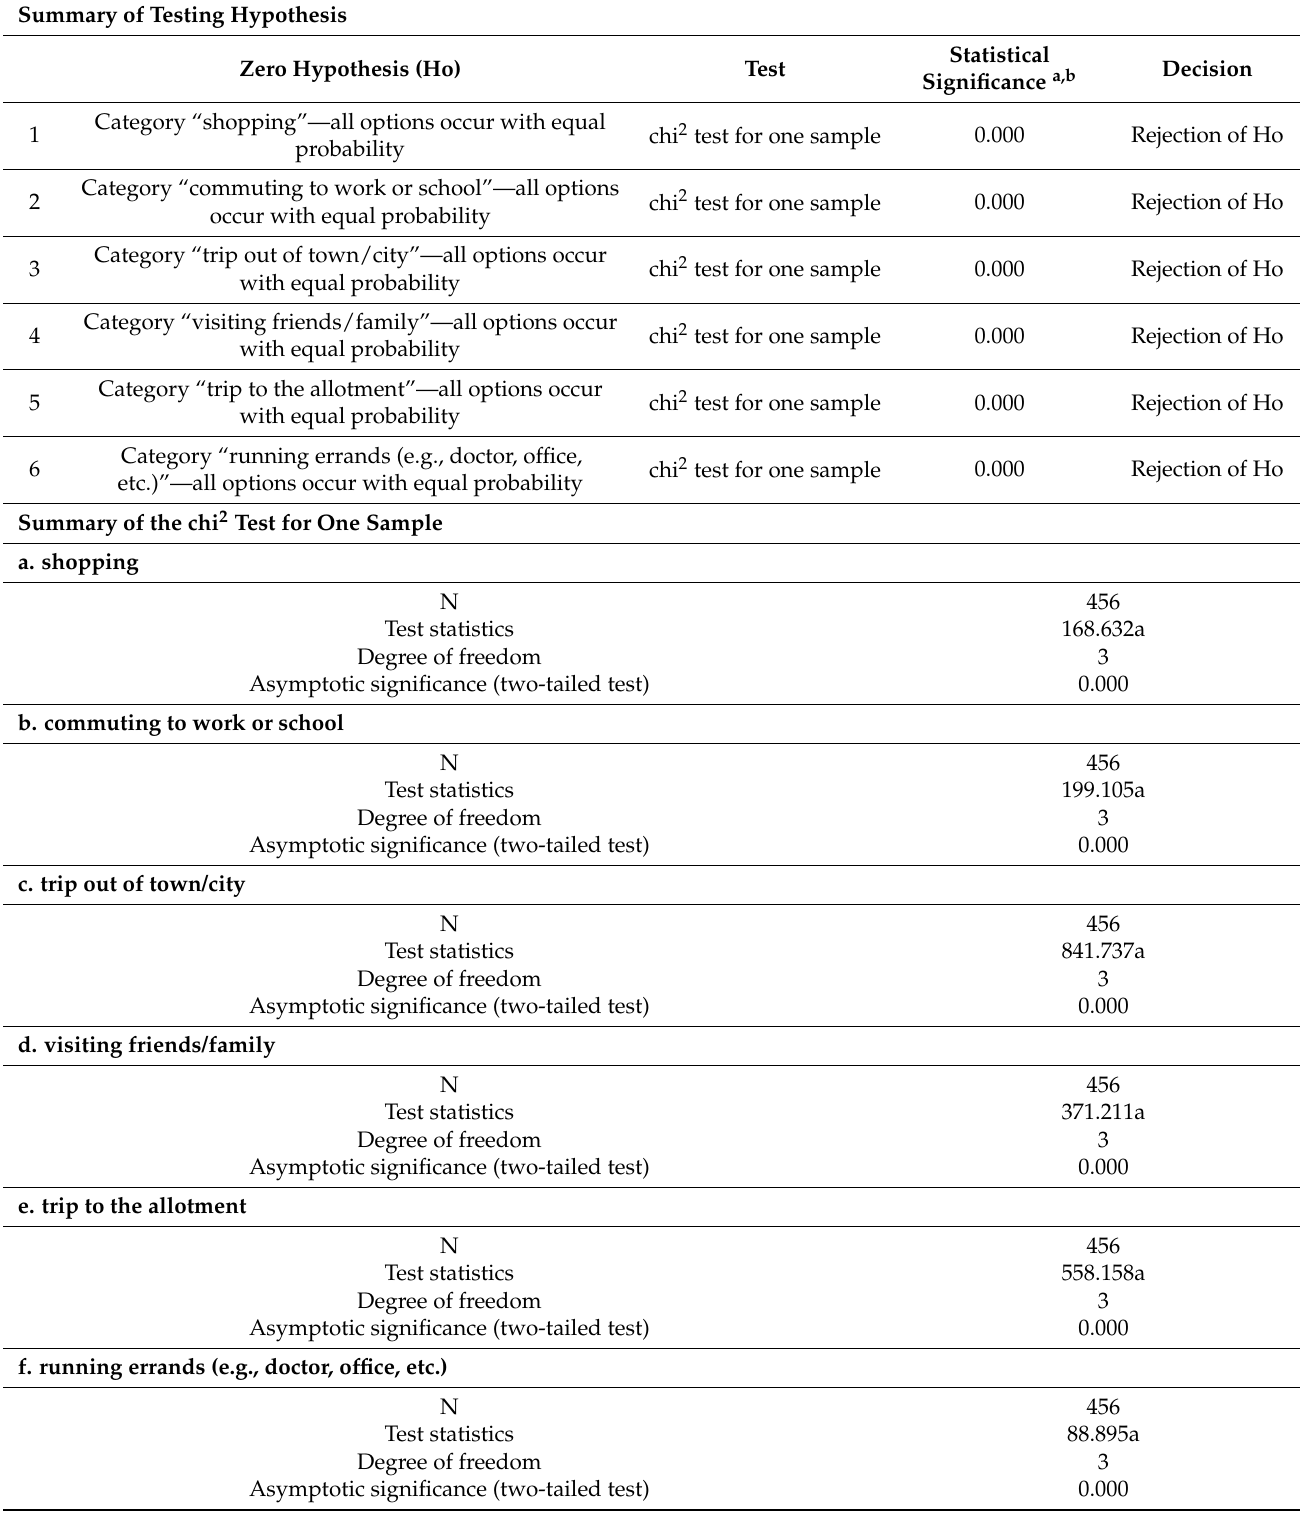
Table A2. Results of the non-parametric chi 2 test for the question: “Assuming you have access to both a traditional bicycle and an e-bike, please indicate which one you would use in each